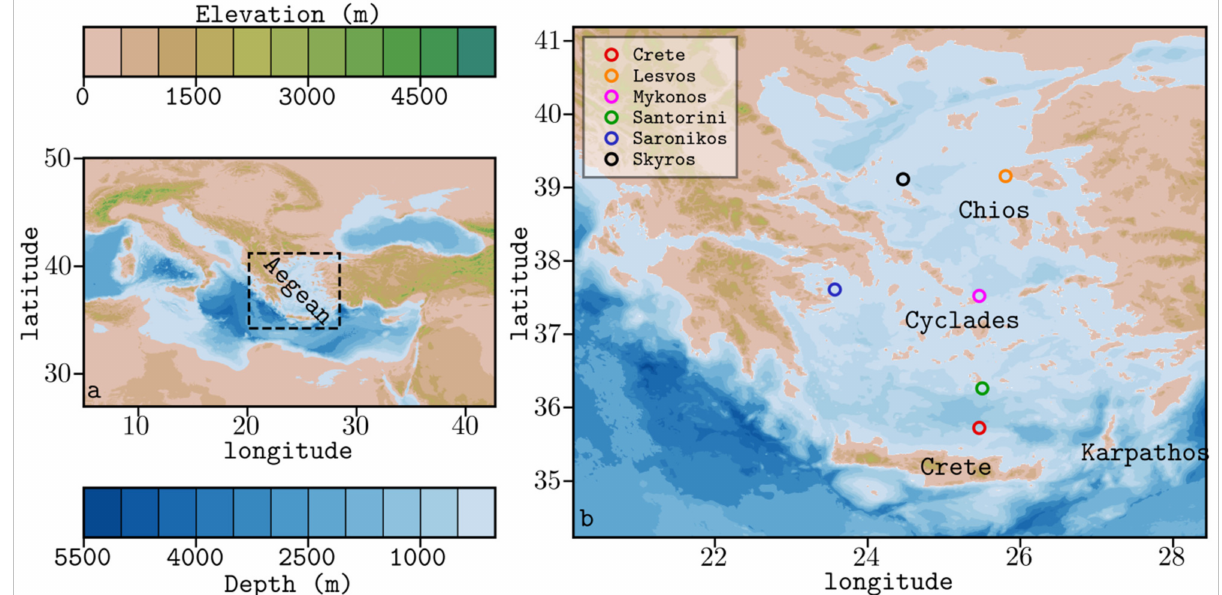
Figure 1. ( a ) Mediterranean region. ( b ) Inner simulation domain that covers the extended area of Aegean. Buoy locations (colored circles) are also